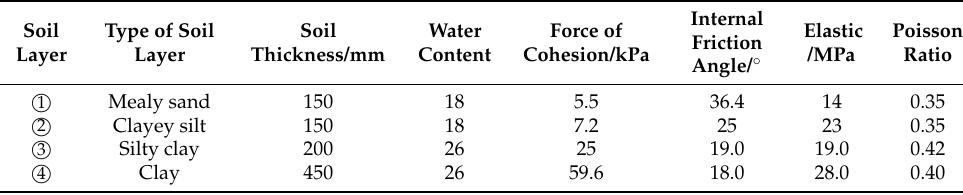
Table 2. Basic physical mechanical properties of layered soils